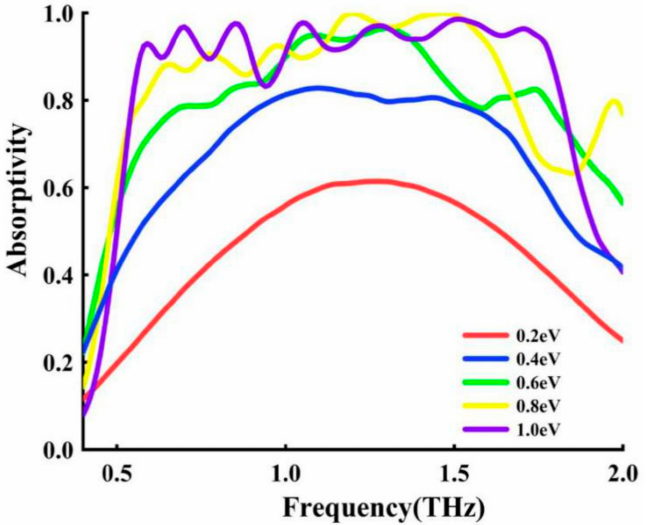
Figure 6. The absorption spectra when the Fermi energy of graphene is 0.2–1 eV under certain other parameters.